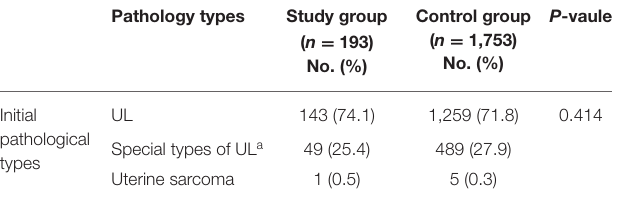
TABLE 4 | Initial pathology types of the two